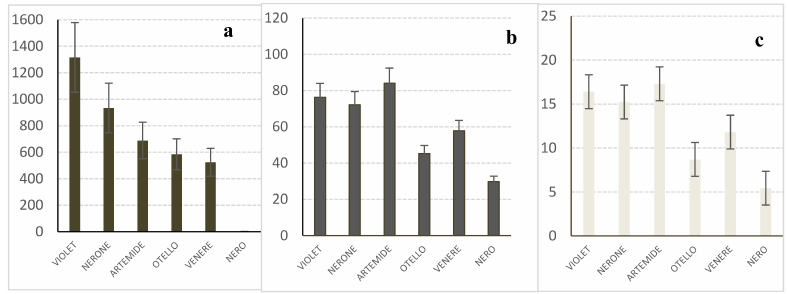
Figure 2. The results obtained from the analyses of the caryopses of different cultivars. ( a ) Anthocyanin content ( µ g/g, as cyanidin-3 glucoside); ( b ) RSA ( µ mol TEAC/g; TEAC = Trolox Equivalent Antioxidant Capacity); ( c ) TPC (mg GAE/g; GAE = Gallic Acid